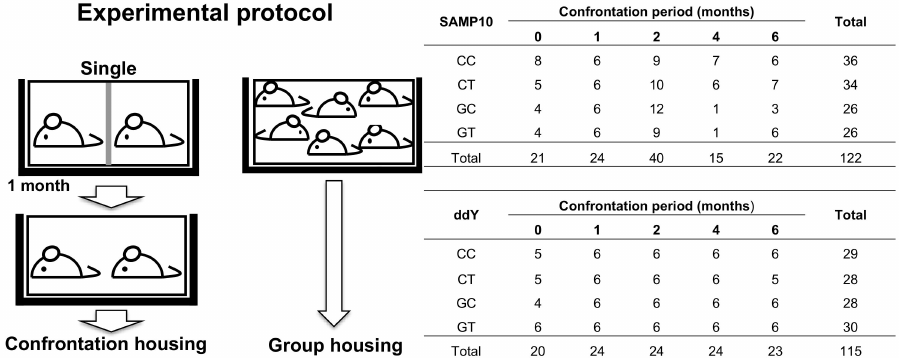
Figure 1. Experimental protocol describing the housing condition. For confrontational housing, a standard polycarbonate cage was divided into two identical subunits by a stainless steel partition. Two mice were housed in the partitioned cage for one month (single housing). These mice were further divided into two groups that ingested theanine or control water. Then, the partition was removed, and subsequently the two mice cohabited the same cage (confrontational housing). Group-housing mice were housed in groups of six. Mice that ingested theanine under confrontational housing, CT; mice that ingested control water under confrontational housing, CC; mice that ingested theanine under group housing, GT; mice that ingested control water under group housing, GC. Confrontation periods were 0, 1, 2, 4 and 6 months. The number of mice for each group is